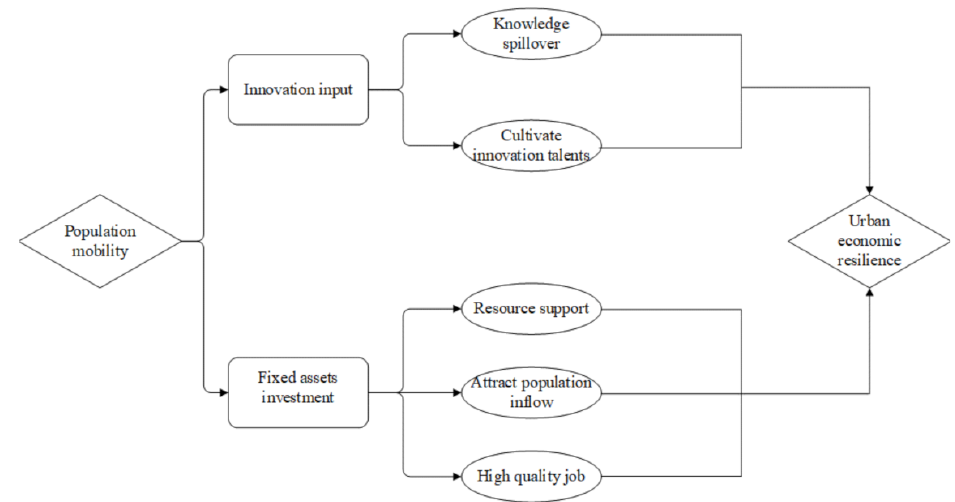
Figure 1. Population mobility and urban economic